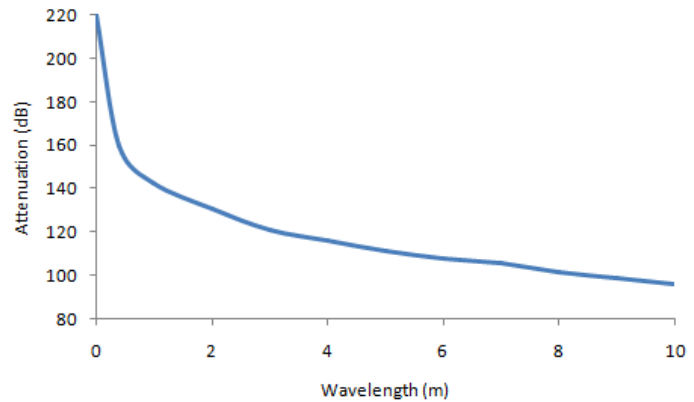
Figure 5. Variation of attenuation Vs wavelength ( λ ).